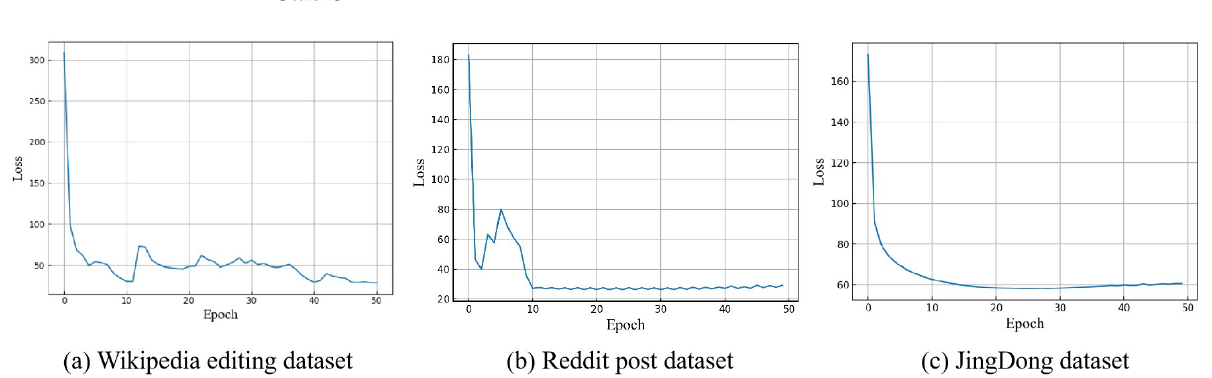
Figure 5. The training loss curves of MRRNN-S over the three datasets.